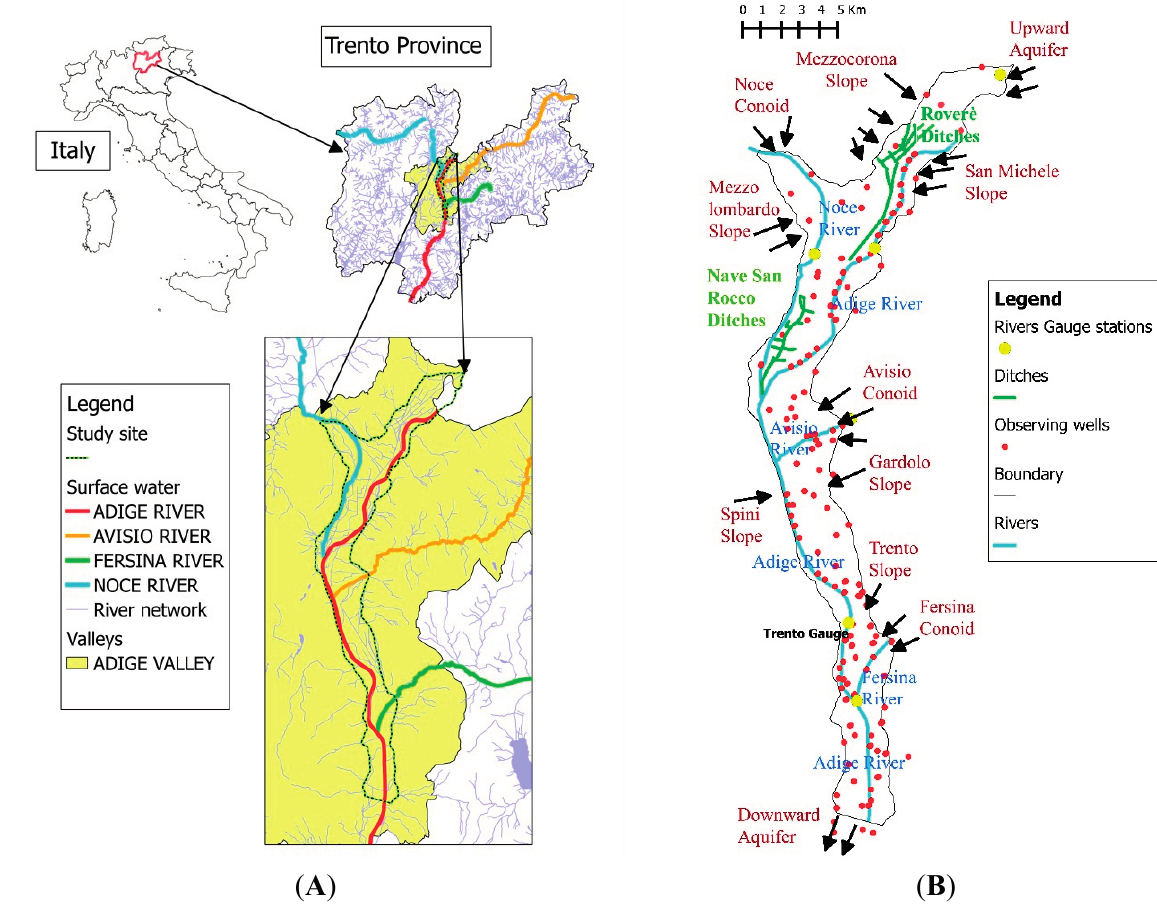
Figure 1. ( A ) The Adige valley is highlighted in yellow, the aquifer considered in this study is delimited by a dashed black line, the red line indicates the Adige River and the three main tributaries, Noce, Avisio and Fersina, are indicated with the light blue, orange and green lines, respectively; ( B ) Conceptual model of the aquifer in the Adige Valley in proximity of